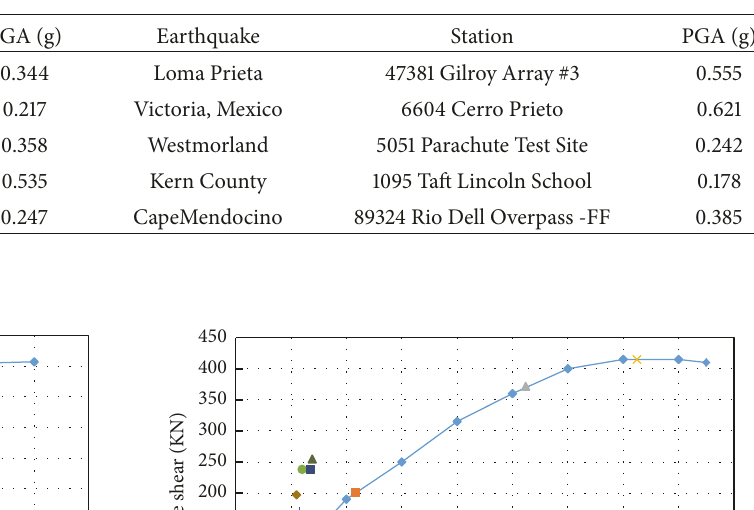
Table 4: Different places of ground motions as per PEER records.